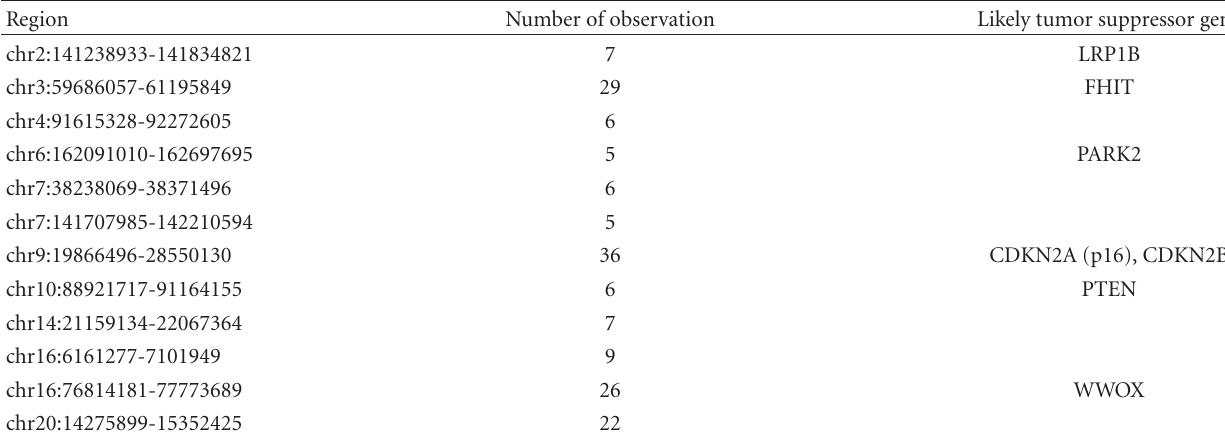
Table 3: Frequent homozygous deletions observed in 178 cancer cell lines. Chromosomal positions are based on March 2006 version of the UCSC Human Genome Browser. Region